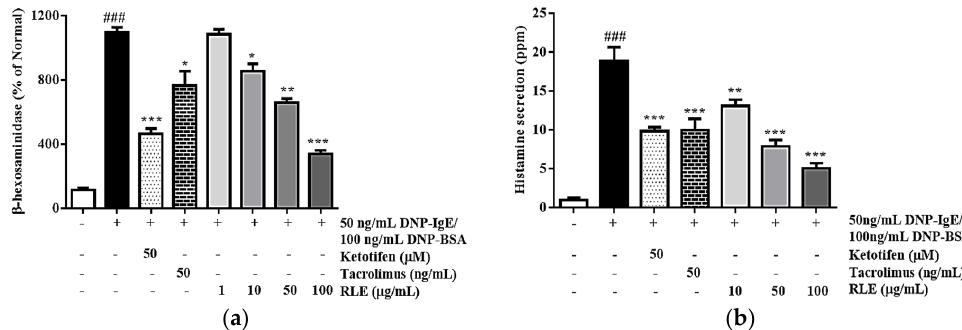
Figure 5. The effects of R. davurica Pall. leaf extract on β− hexosaminidase release ( a ) and histamine ( b ) in RBL − 2H3 cells. Data are presented as the mean ± SD. # and * indicate significant differences between the non − treated cells and LPS − induced groups, respectively. ### p < 0.001 vs. the non − treated group. *, ** and *** p < 0.05, 0.01 and 0.001 vs. the DNP − IgE/BSA − sensitized control, respectively.